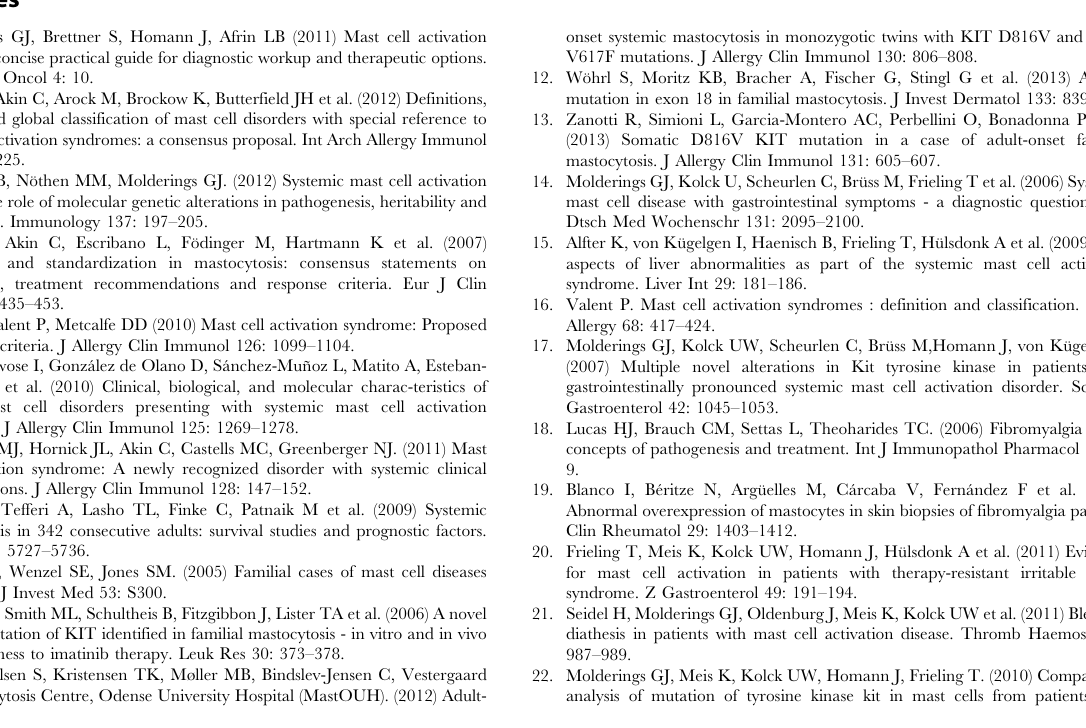
Table S1 Characteristics of the study population by participant status. Table S2 Questionnaire to diagnose mast cell activation disease from clinical findings. MCAD was diagnosed after exclusion of relevant differential diagnoses, if (1) 11 or more items were applicable or (2) if potentially mast cell mediator-related symptoms occurred in five or more different organs and/or tissues. Table S3 Sequences of the forward and reverse primers used for PCR